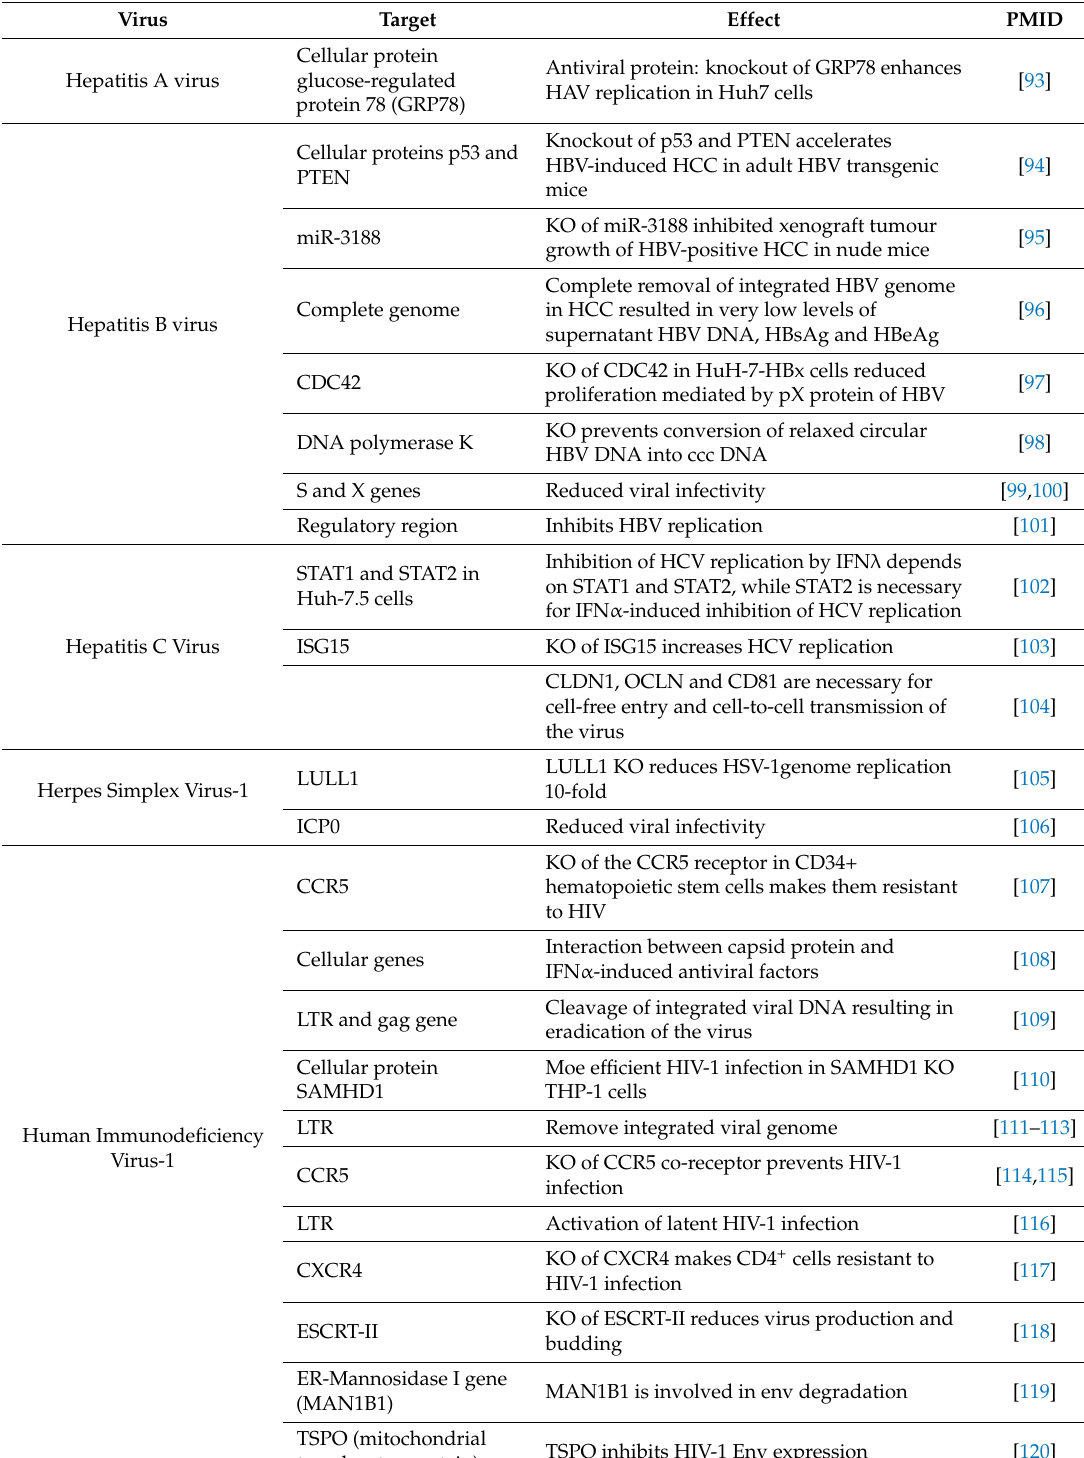
Table 2. Overview of CRISPR/Cas9 applications in virus-host